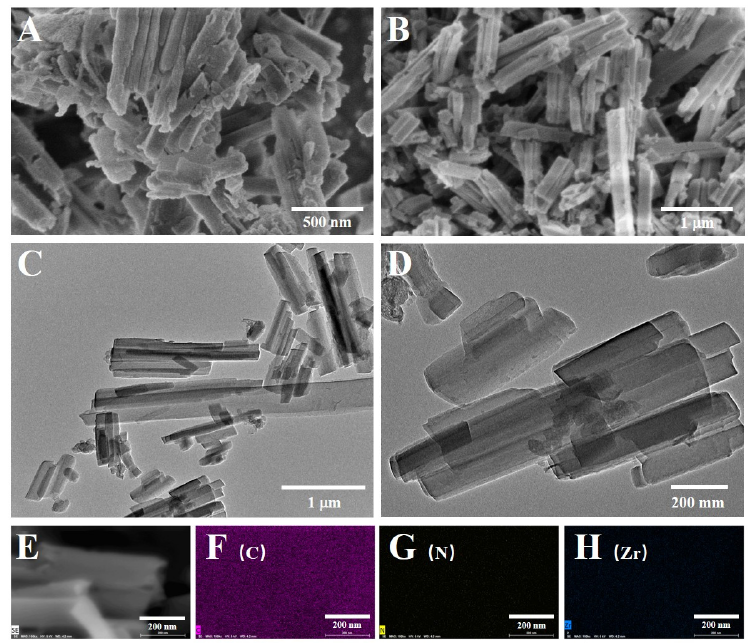
Figure 2. SEM ( A , B ), TEM ( C , D ) images and the corresponding EDS elemental mapping images ( E – H ) of NU-1000(Zr).